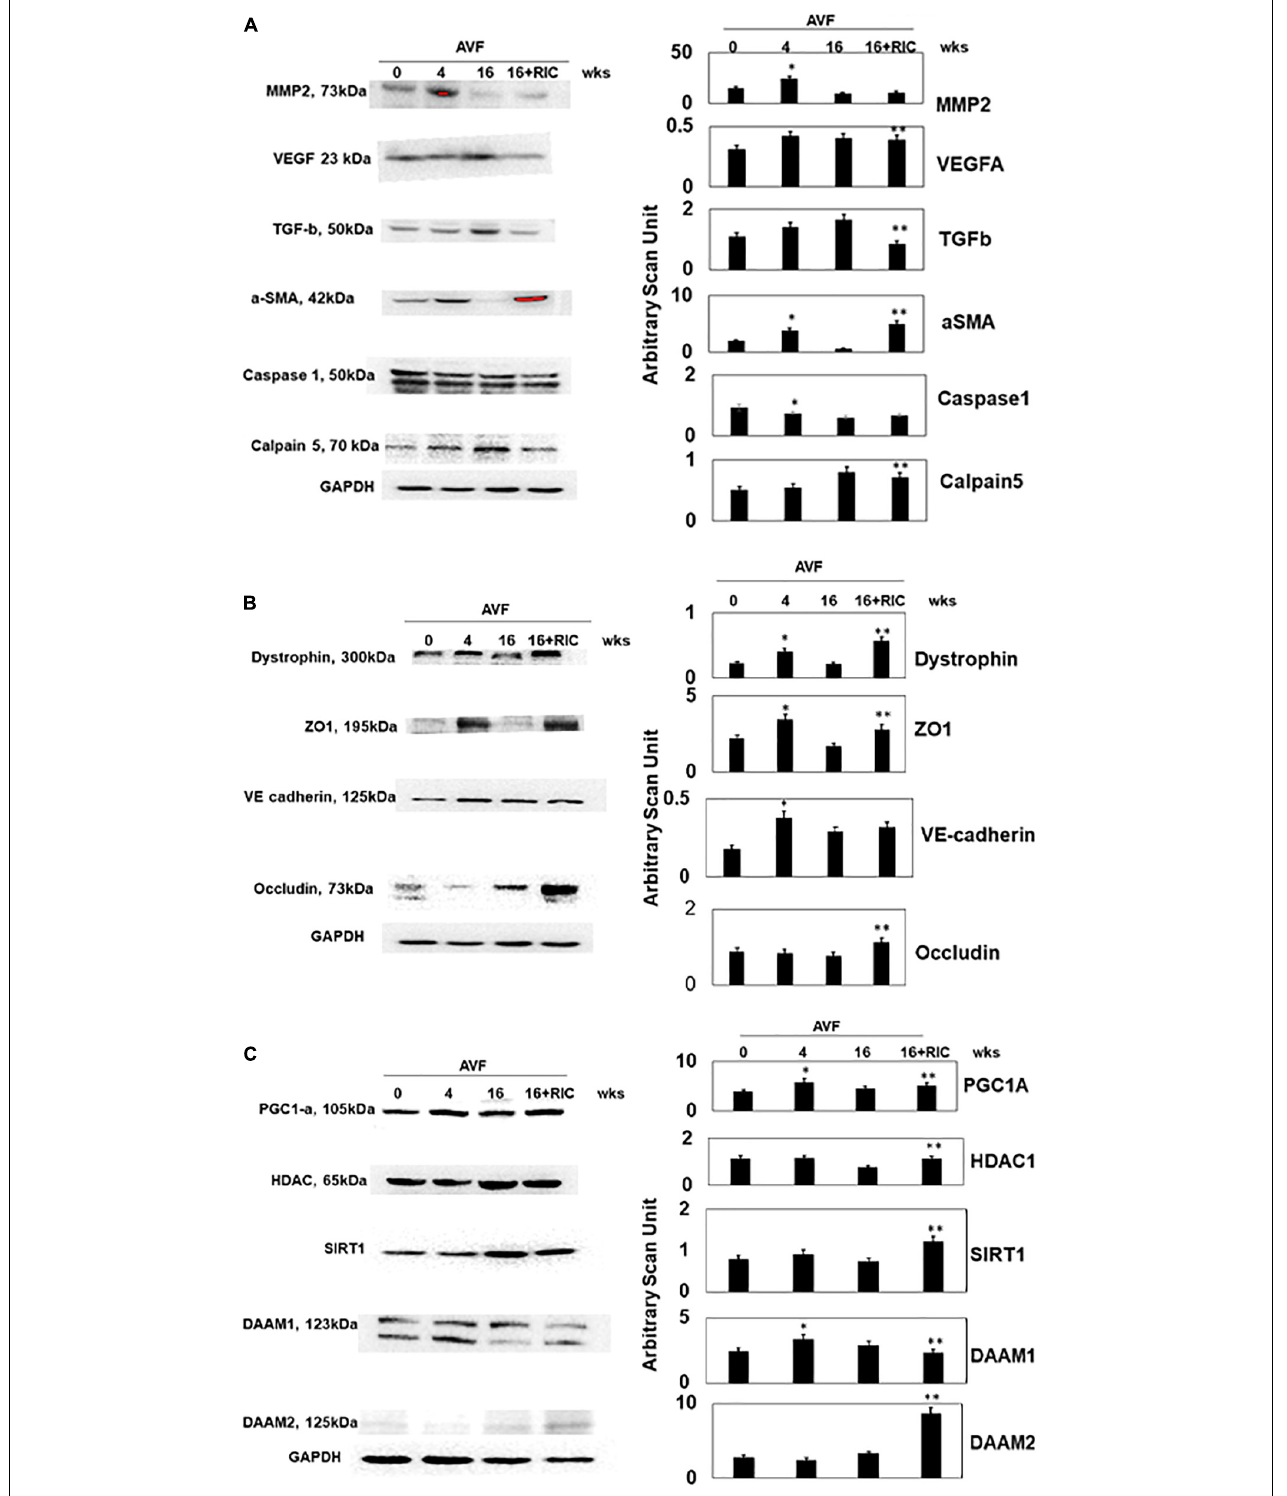
FIGURE 4 | (A) The Western blot analysis of inciting cardiac levels of MMP2, VEGF, TGF-b, a-SMA, caspase1, and calpain5. Bar graph of relative scan unit representation with ± SD from n = 5–8. (B) The Western blot analysis of intercellular connecting cardiac levels of dystrophin, ZO1, VE cadherin, and occludin. Bar graph of relative scan unit representation with ± SD from n = 5–8. (C) The Western blot analysis of regenerative cardiac levels of PGC1-a, HDAC, SIRT1, DAAM 1, and DAAM 2. Bar graph of relative scan unit representation with ± SD from n = 5–8. * and ** indicate significant difference ( p < 0.05) either to “sham without RIC” or to “0”